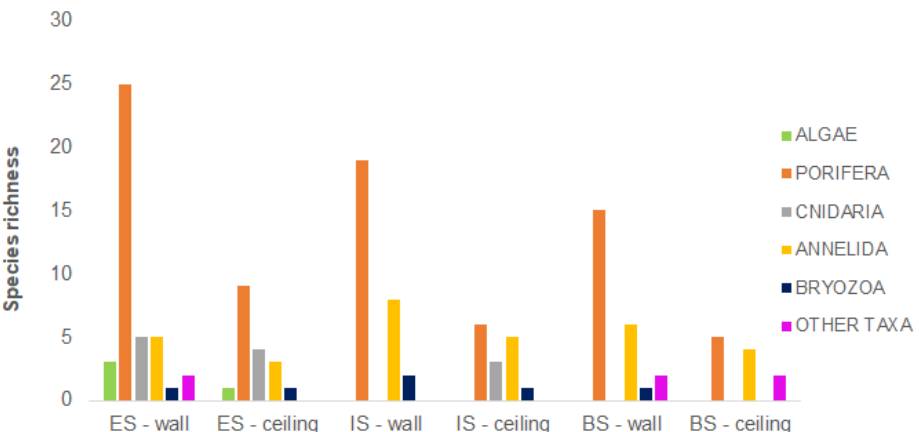
Figure 5. Species richness of the benthic organisms on the wall and ceiling of the three sectors of the Elle cave: ES: Entrance; IS: Intermediate sector; BS: Bottom sector.